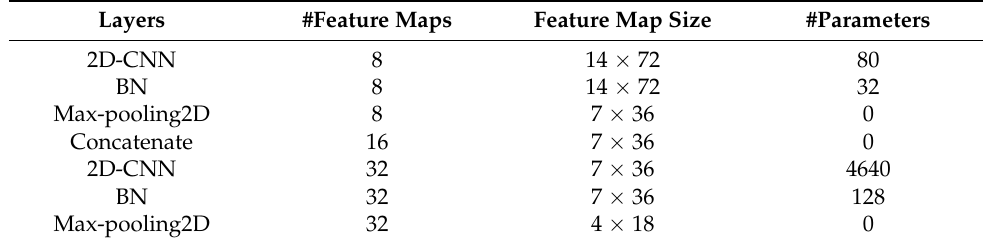
Table 3. Layer 2 construction.